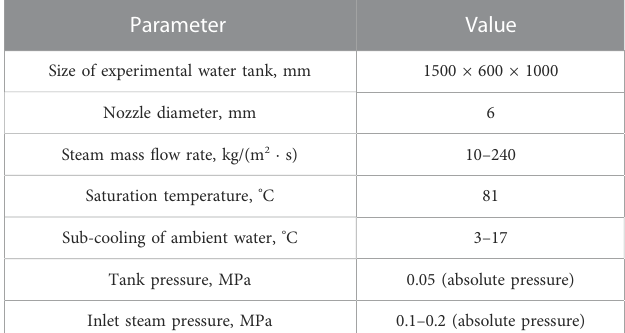
TABLE 1 Experimental